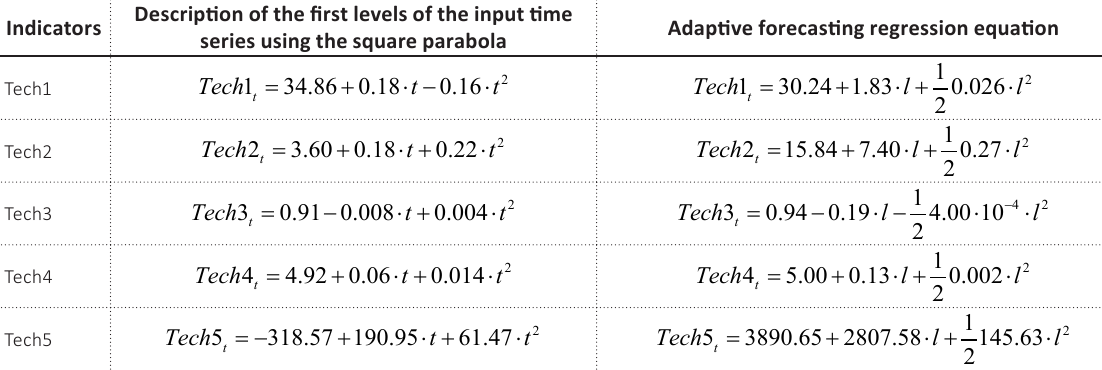
Table 3. Intermediate calculations of the trend equation of adaptive forecasting in the context of information technologies for 1999–2018 Indicators Description of the first levels of the input time Adaptive forecasting regression series using the square parabola